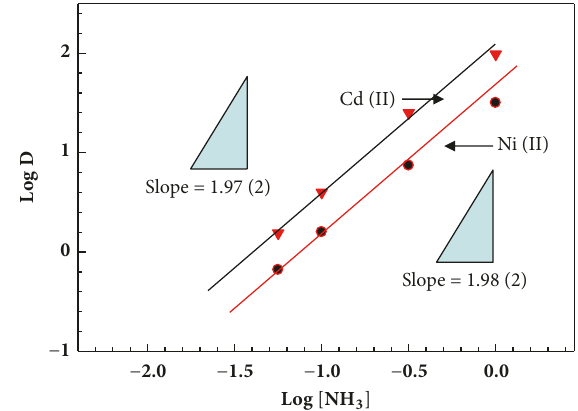
Figure 5: Plot of logD vs. log[NH 3 ] for Cd 2+ and Ni 3+ with H 8 L under the same reaction condition of Figure 3.